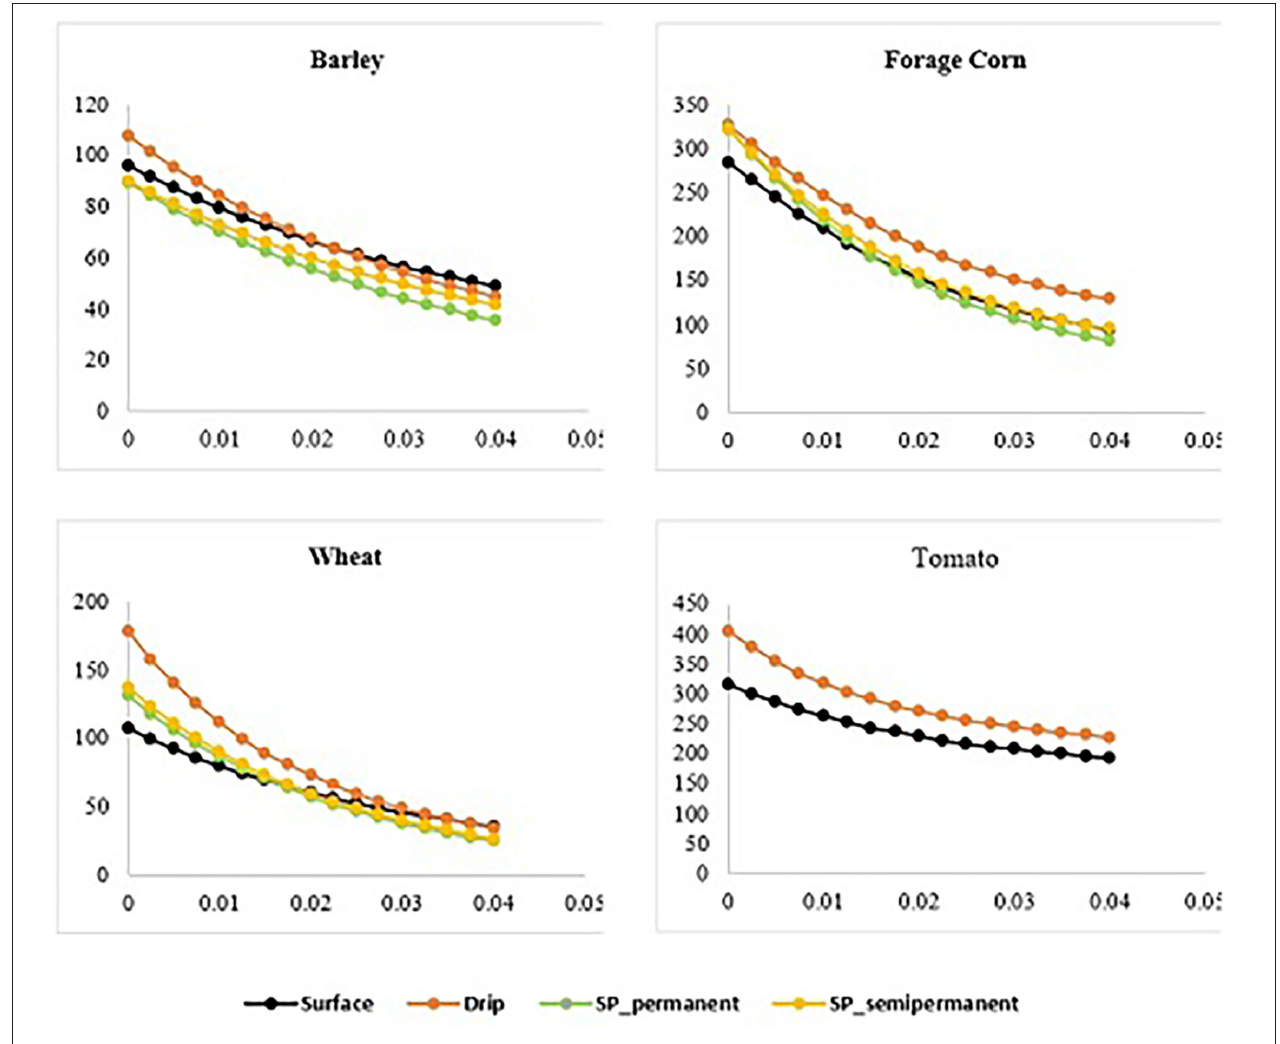
FIGURE 4 | SERF results for Barley, Forage corn, Wheat, and